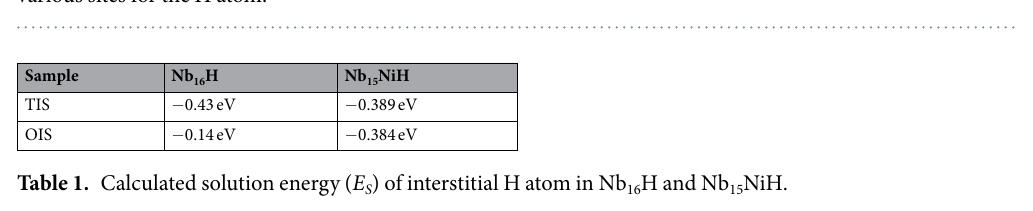
Figure 1. Schematic illustrations of ( a ) Nb 15 NiH, ( b ) tetrahedral interstitial site (TIS), and ( c ) octahedral site (OIS). The green and black spheres represent Nb and Ni atoms, respectively. The small orange spheres stand for various sites for the H atom.